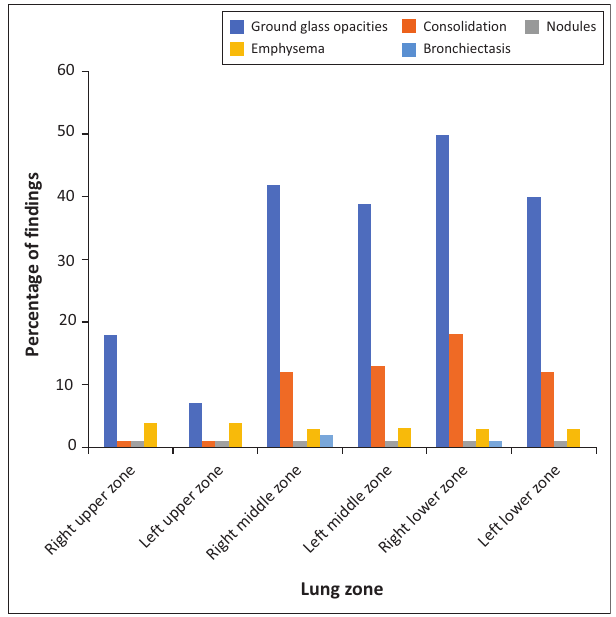
FIGURE 2: Proportions of the zonal distribution and description of pathological findings on chest radiographs. The right lower zone was found to have the highest frequency of described COVID-19 changes, while the left upper zone was relatively spared.